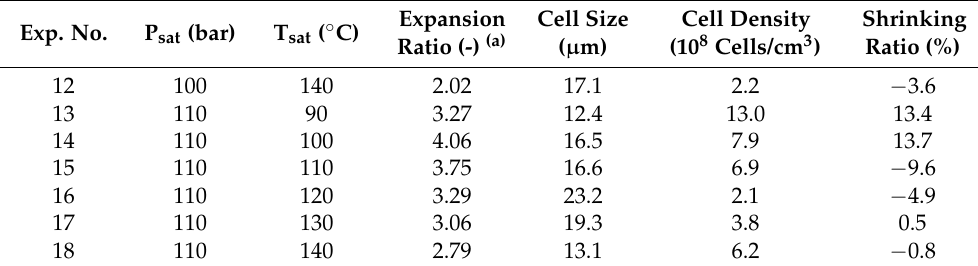
Figure 5. Comparison of surface morphology of TPU foams obtained from different saturation temperature and saturation pressure.